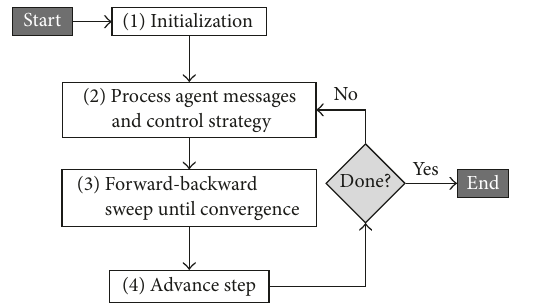
Figure 2: Schedule of each process as defined in Model C ++